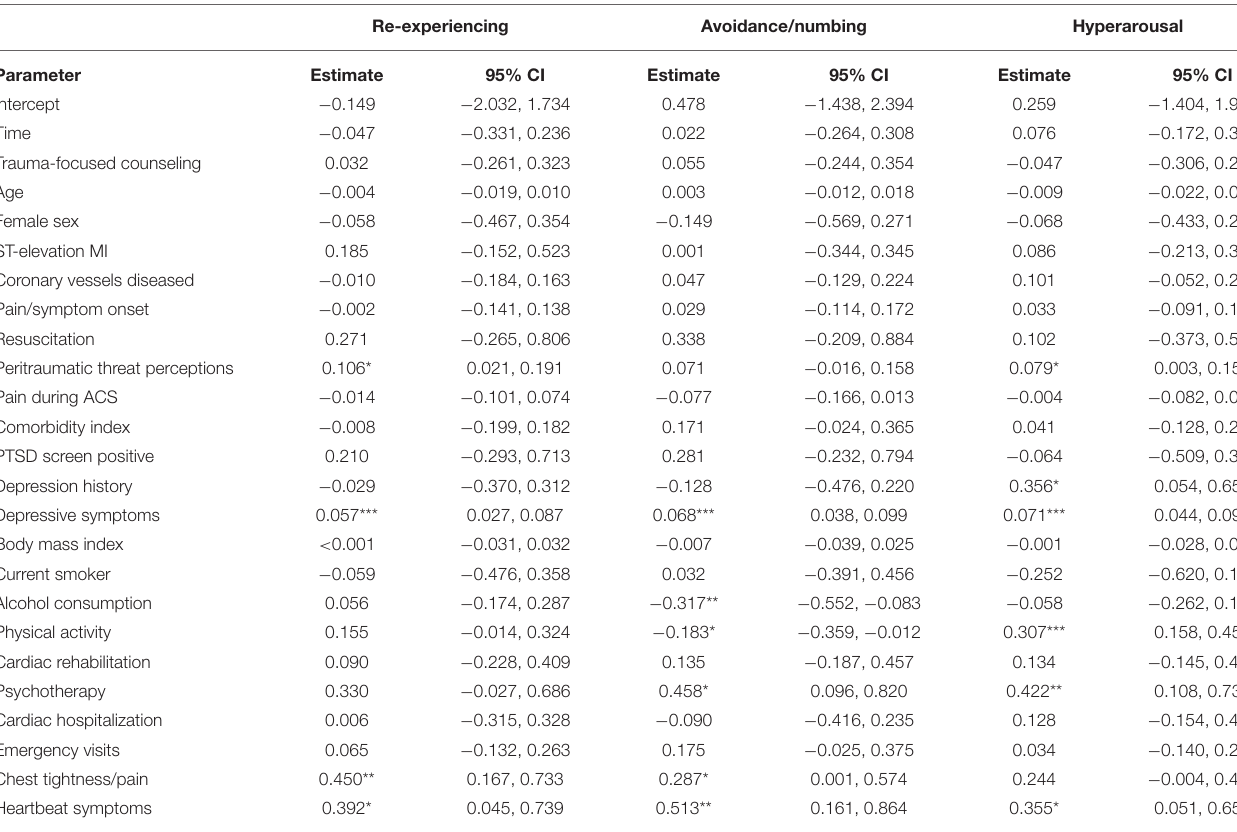
TABLE 3 | Multivariable relationships with PTSD symptom clusters over 12 months. Re-experiencing Avoidance/numbing